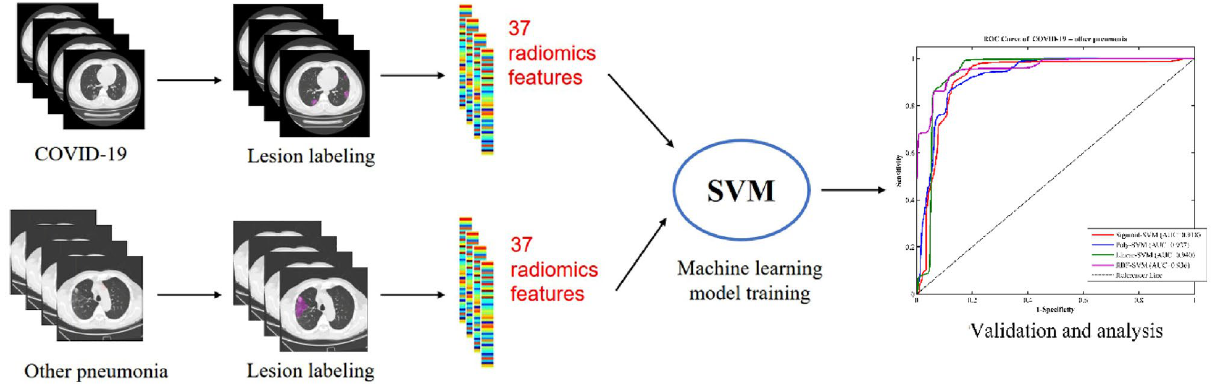
Figure 1. The flow of our proposed machine learning algorithm SVM with radiomics features for classification of COVID-19 and other